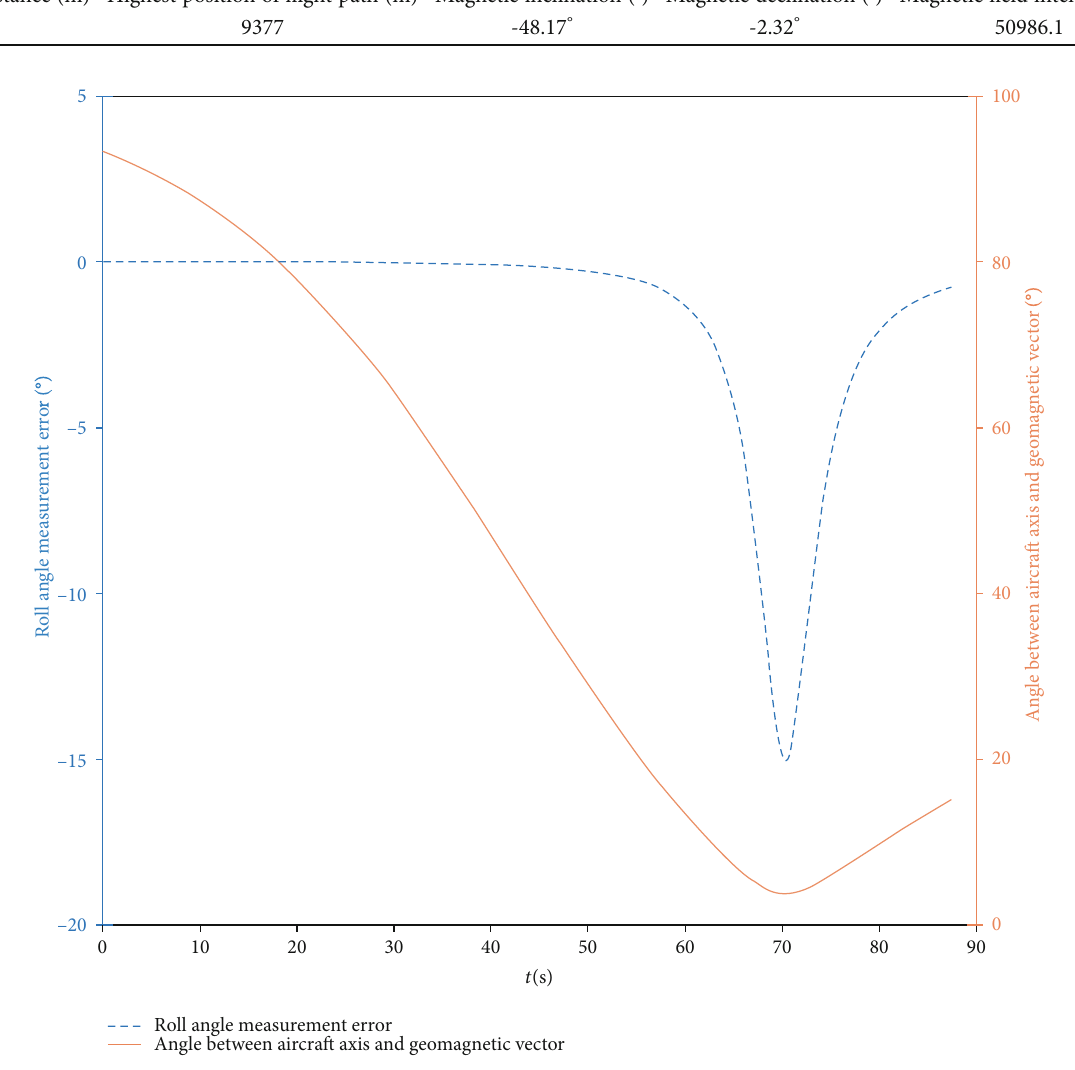
Figure 2: Comparison of roll angle error and angle change between aircraft axis and geomagnetic fi